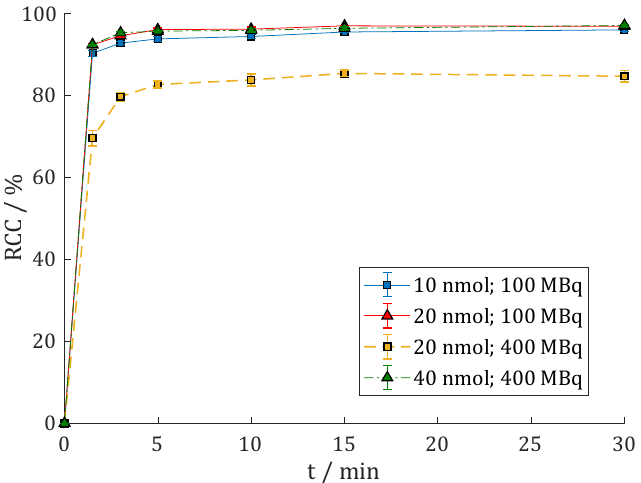
Figure 3. Reaction kinetics (radiochemical conversion (RCC) in %) of [ 68 Ga]Ga-DOTAGA.Glu.(FAPi) 2 68 Ga ‐ 7 in 1 M HEPES (pH = 4.5) at 95 °C with 100 MBq 68 Ga (n = 4) or 400 MBq 68 Ga (n = 2).